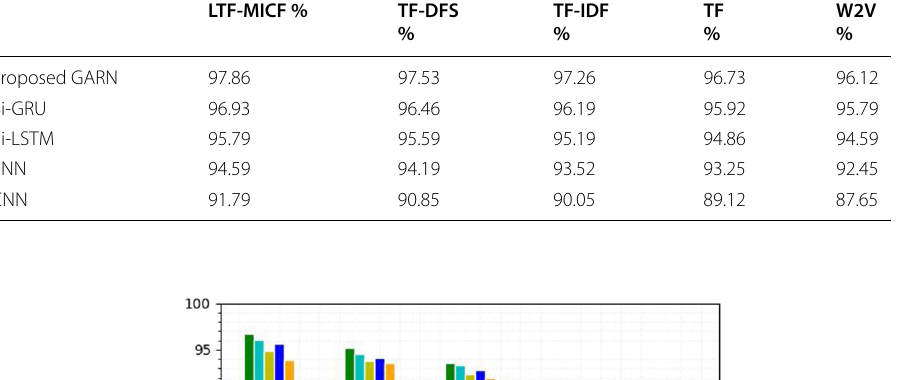
Table 4 Accuracy of the proposed and existing classifiers with term weights Classifiers